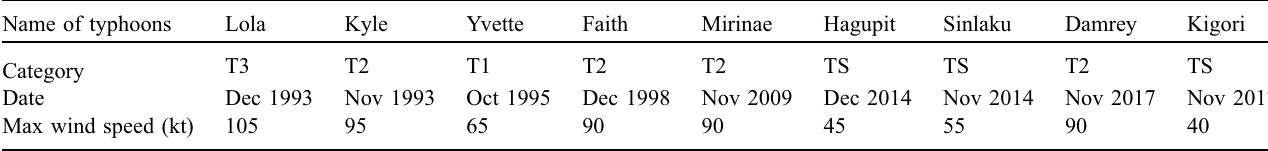
Table 3. List of typhoons and its characters affecting the Khanh Hoa coast including VPB during 1988 to 2019 (Source: